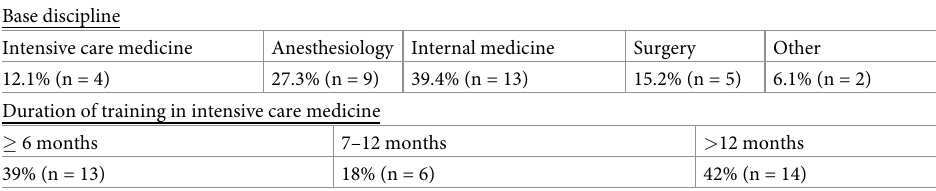
Table 2. Residents’ base disciplines and duration of intensive care